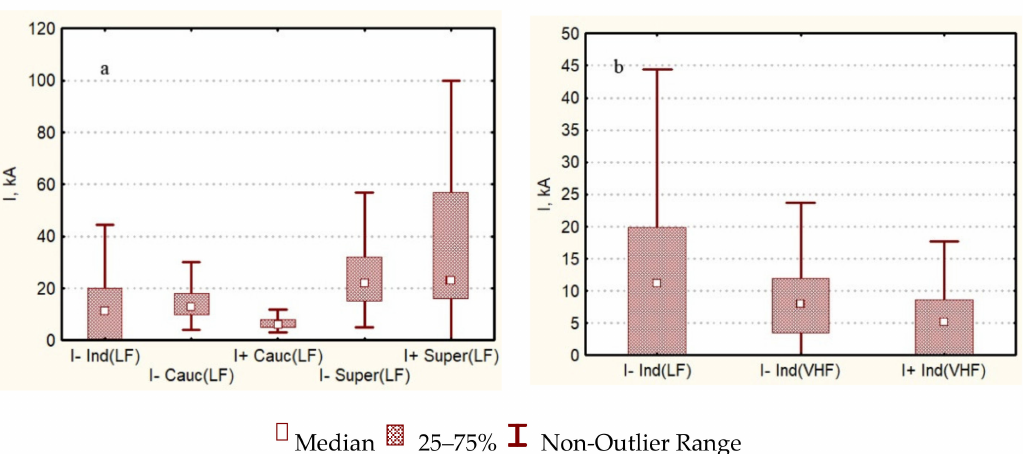
Figure 6. Box-and-whisker diagram of samples of flash current I (kA) in the LF range (left diagram ( a )) and in the LF and VHF range (right diagram ( b )). The abscissa axis (groups of clouds): India (I − Ind (LF)); north Caucasus (I − Cauc (LF)); north Caucasus (I+ Cauc (LF)); supercell Cb (I − Super (LF)); supercell Cb (I+ Super (LF)); India (I − Ind (VHF)); (I − Ind (VHF)). I − and I+ indicate the maximum currents (positive I+ and negative I −